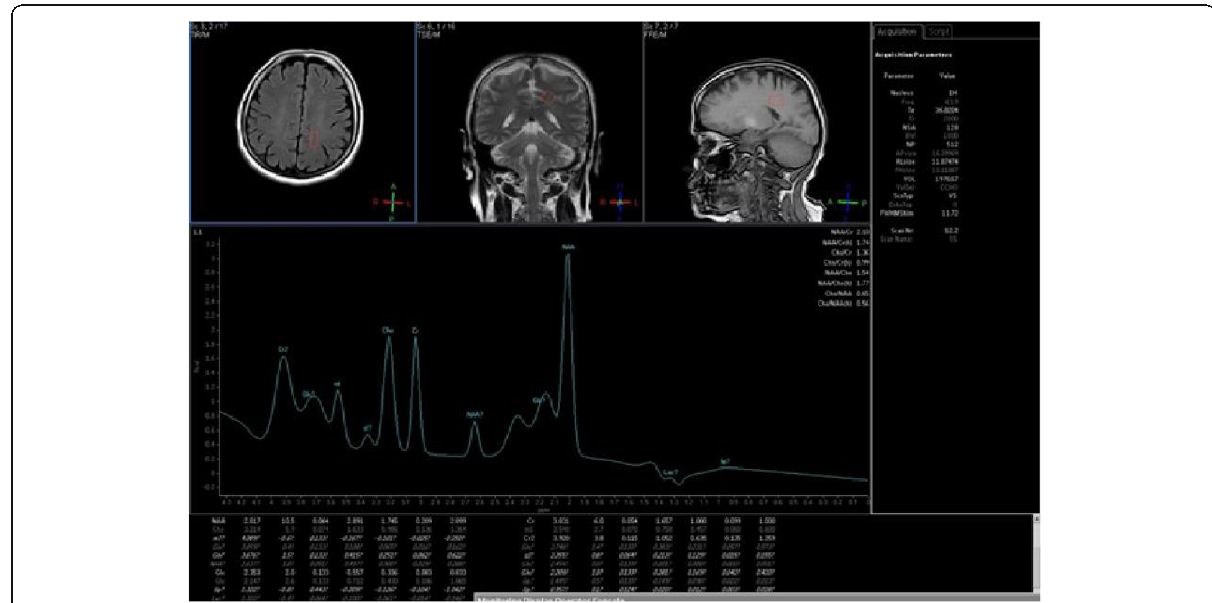
Fig. 3 MRS at posterior cingulate gyrus in patients with cognitive impairment. Spectroscopic voxel of interest was done at posterior cingulate gyrus in sagittal, coronal, and axial plans in patients with impaired Visuo-spatial function score. Curve showed that NAA/Cr ratio was elevated ( R = 0.409 and p value =